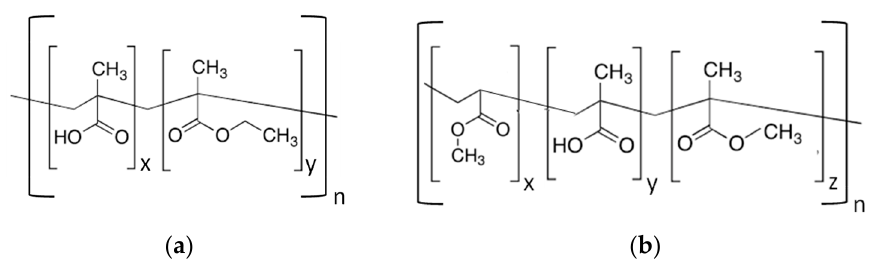
Figure 2. Chemical structure of ( a ) EUDRAGIT ® L 30 D-55 and ( b ) EUDRAGIT ® FS 30 D.